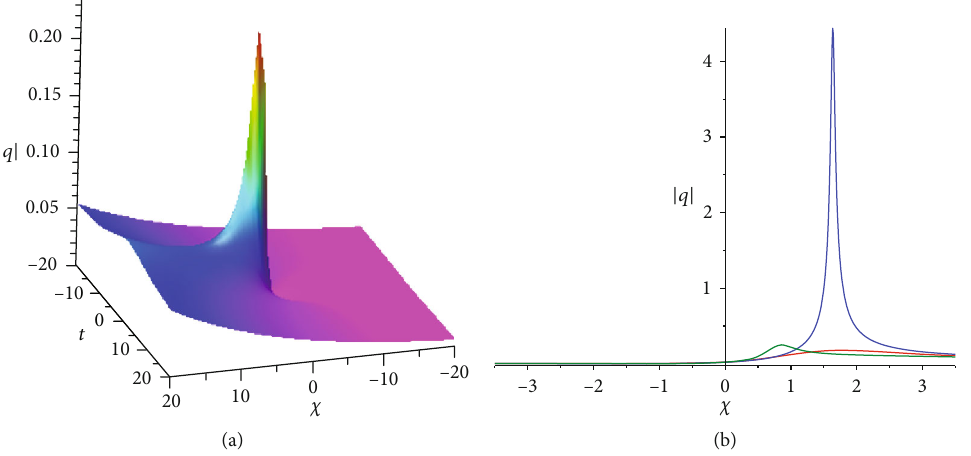
∣ and (b) its rogue